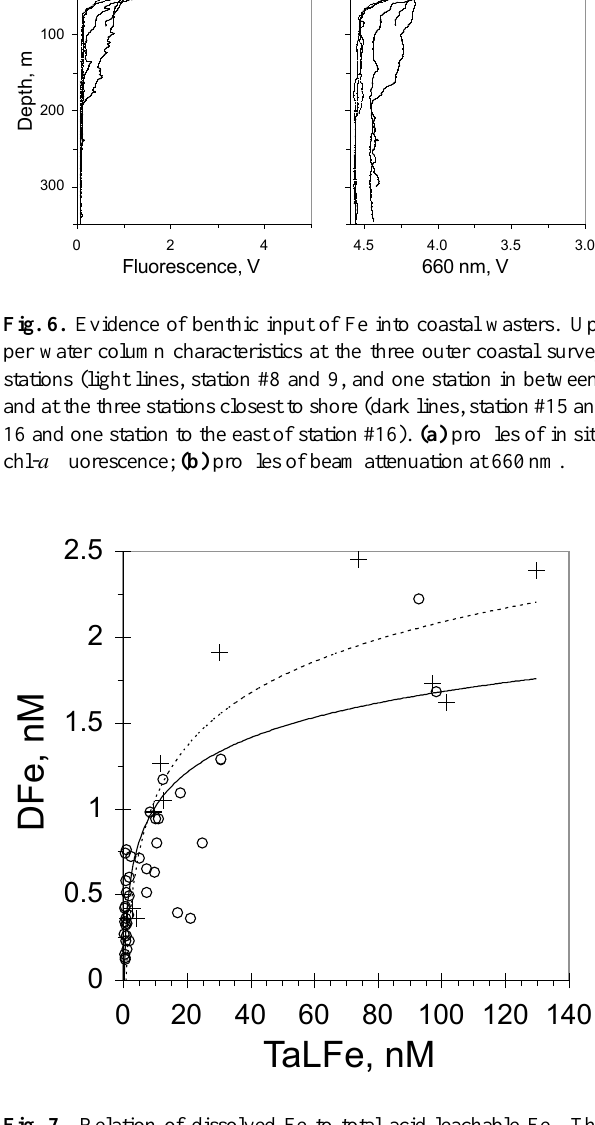
Fig. 7. Relation of dissolved Fe to total acid leachable Fe. The lower, dark regression line utilizes data from all stations. The upper, dashed regression line utilizes data from only the coastal survey stations (+, station #8–9,